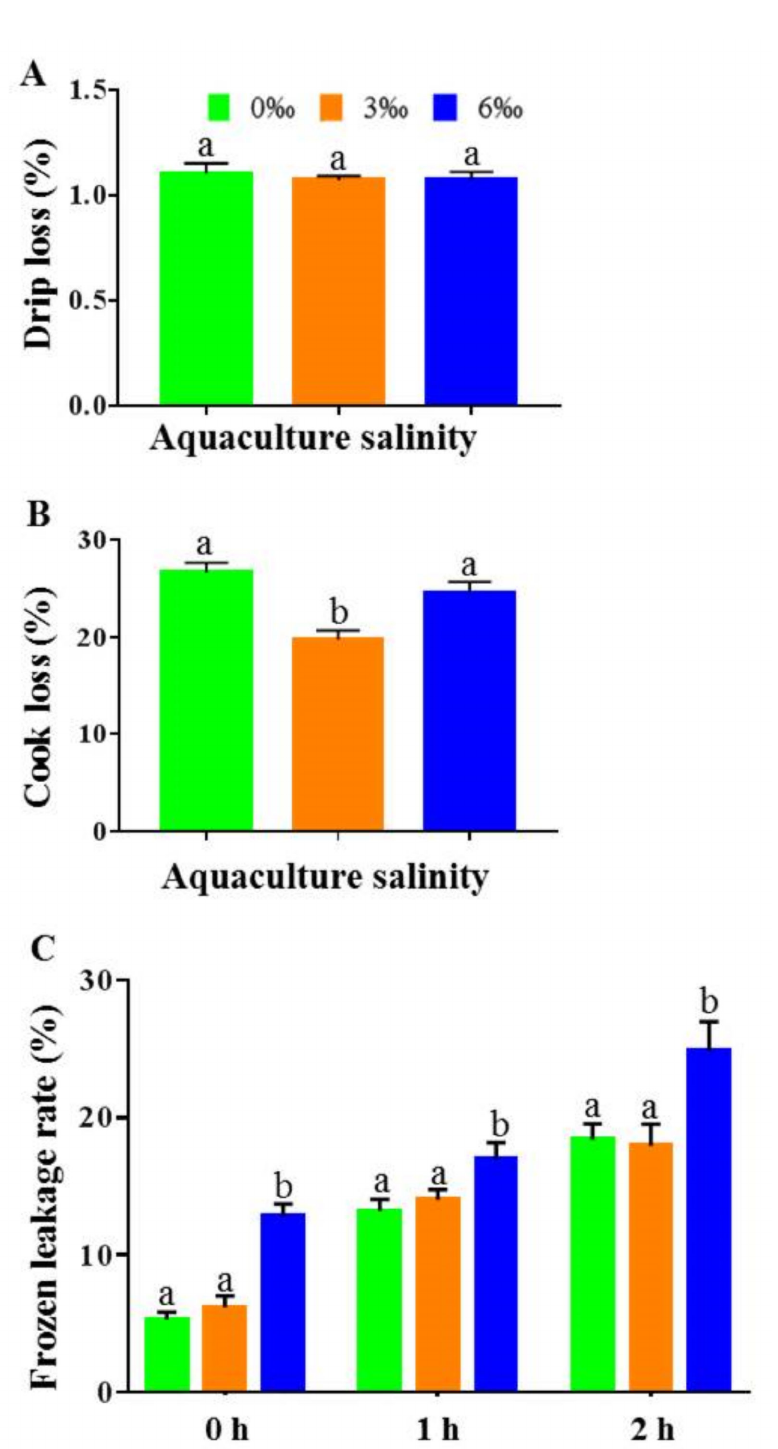
Figure 2. Water-holding capacity of muscle of grass carp cultured at different salinities (0‰, 3‰, and 6‰). ( A ), Drip loss; ( B ), Cook loss; ( C ), Frozen leakage rate. Different lowercase letters indicate significant differences among different salinities ( p <